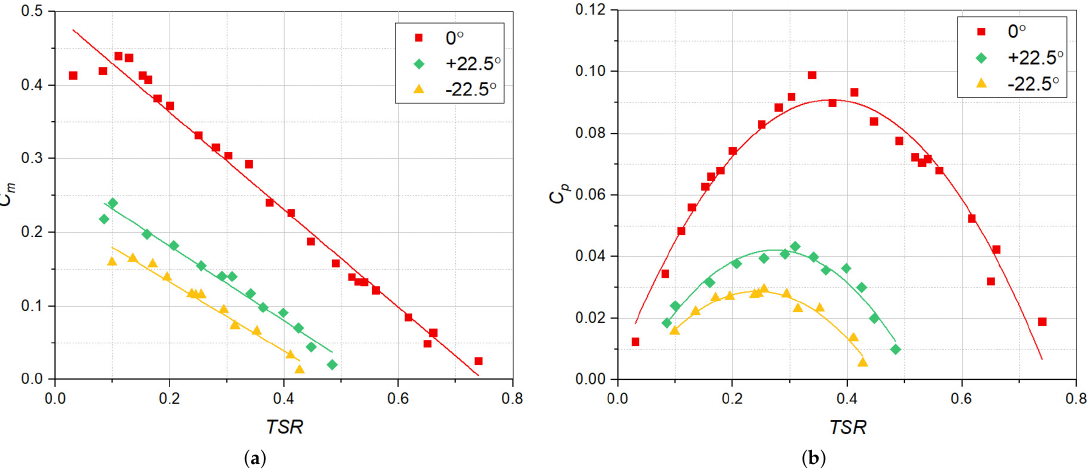
Figure 11. Variation in C m and C p with the TSR for the different blade placement angles ( α ). ( a ) C m vs. TSR , ( b ) C p vs. TSR